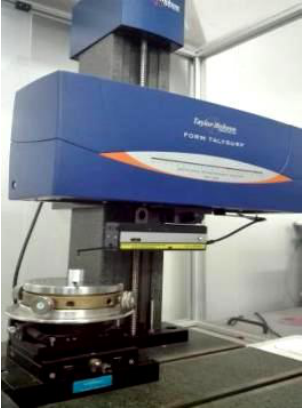
Figure 13. Testing quality of the workpiece surface.